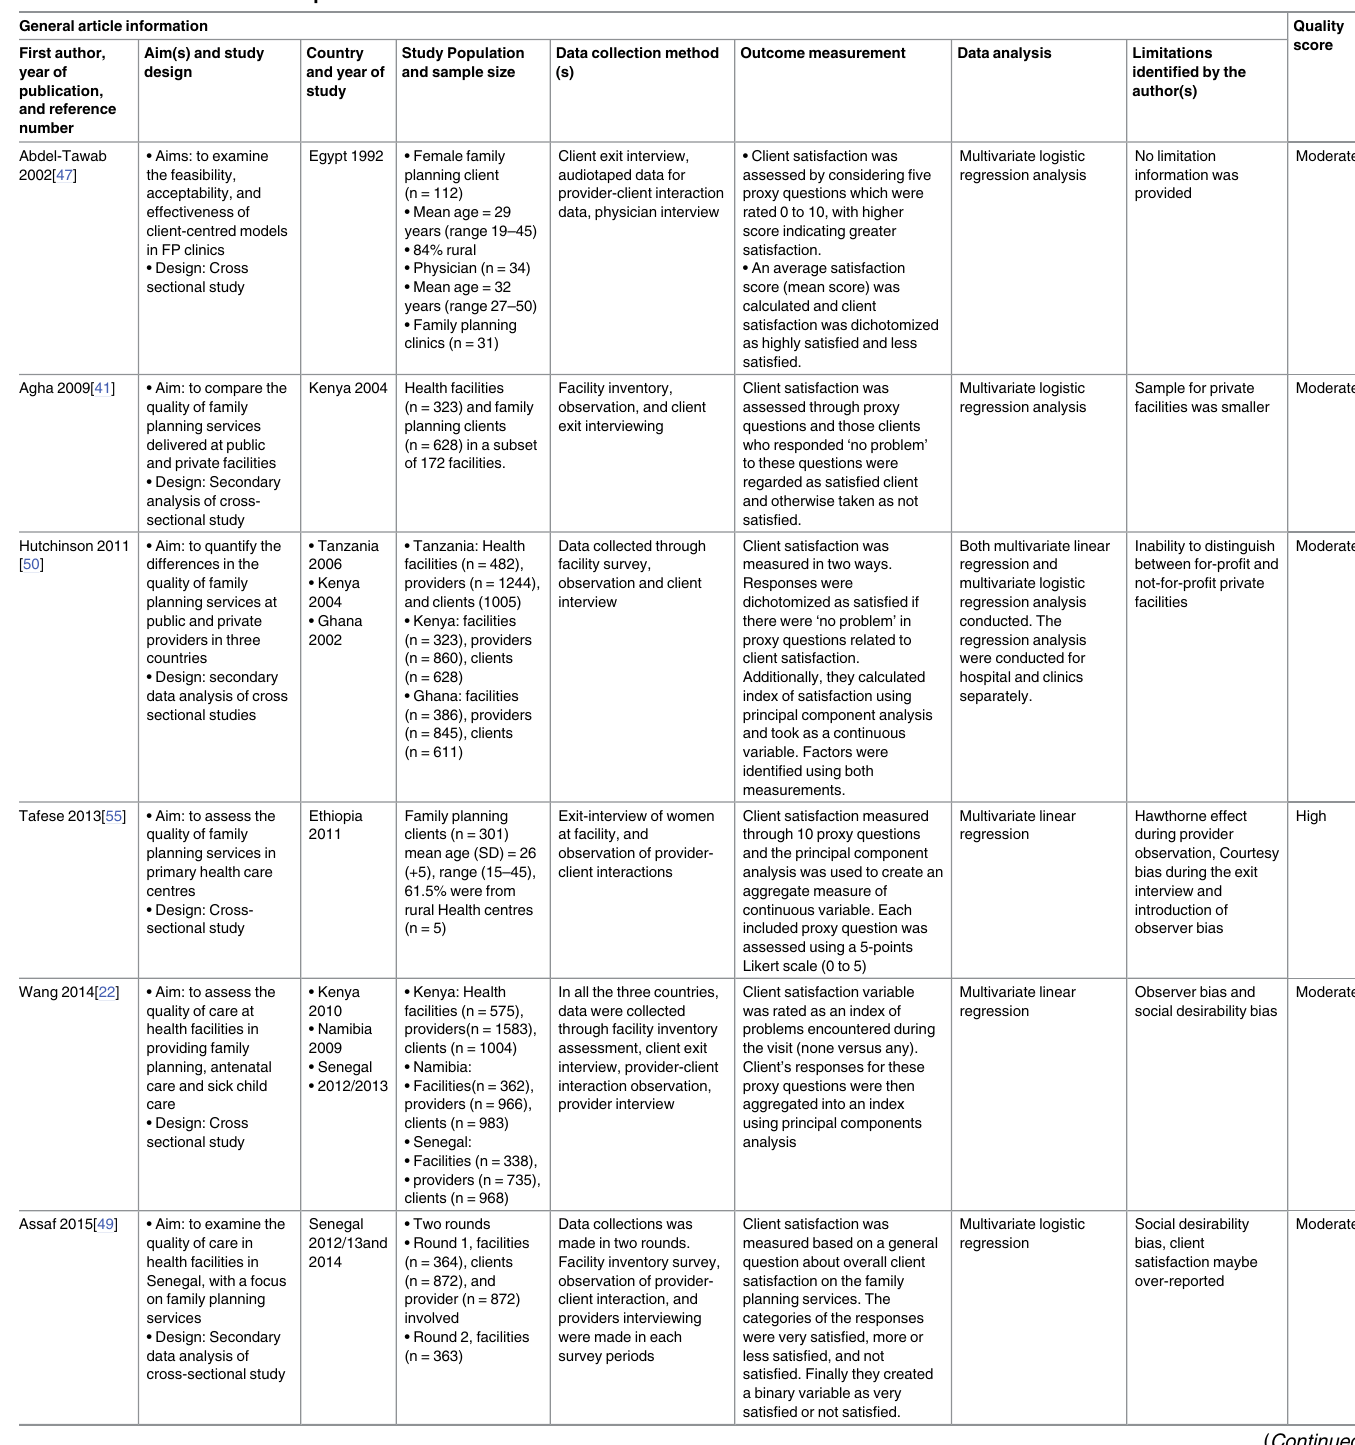
Table 1. Characteristics of the quantitative studies included in the